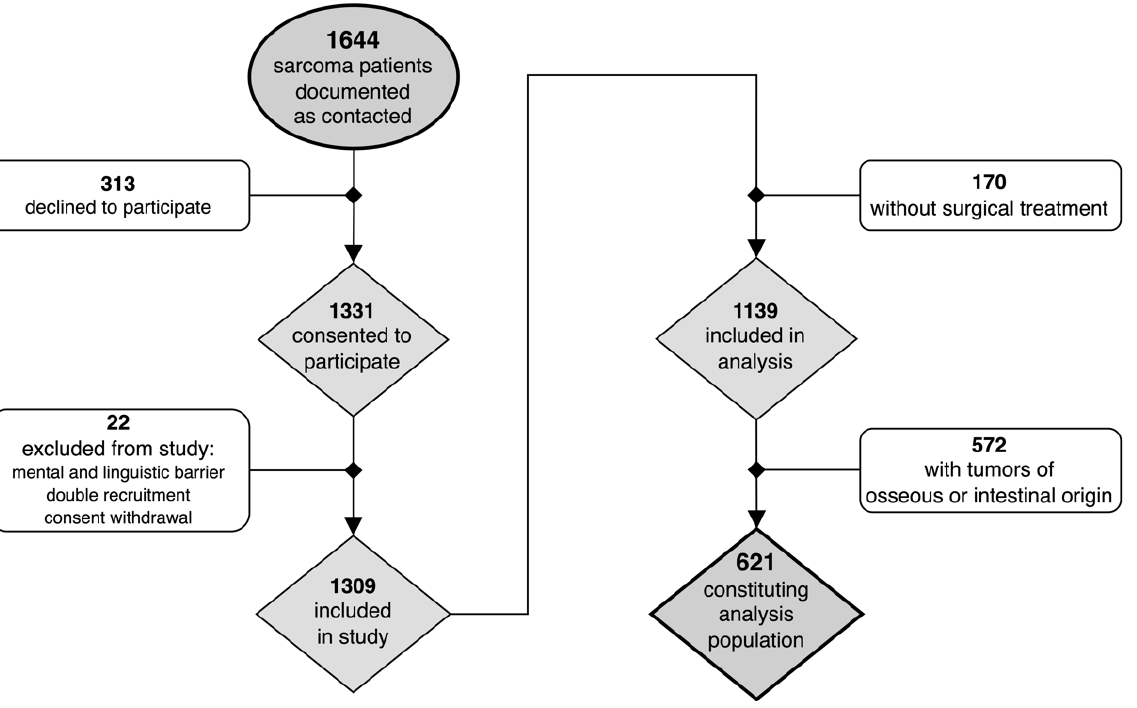
Figure 1. Flow diagram of patients recruited as part of the original PROSa study protocol and eligibility criteria for this present analysis. Table 1. Sarcoma subtypes.